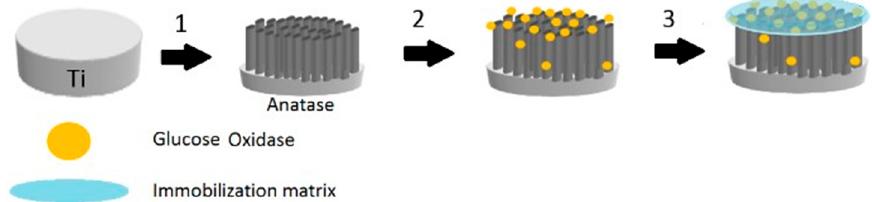
Figure 1. Scheme showing the construction of the glucose biosensor, step 1: growing and crystallization of titanium nanotubes; step 2: deposition of glucose oxidase molecules; and step 3: deposition of a polymeric cover (Chitosan) as immobilization